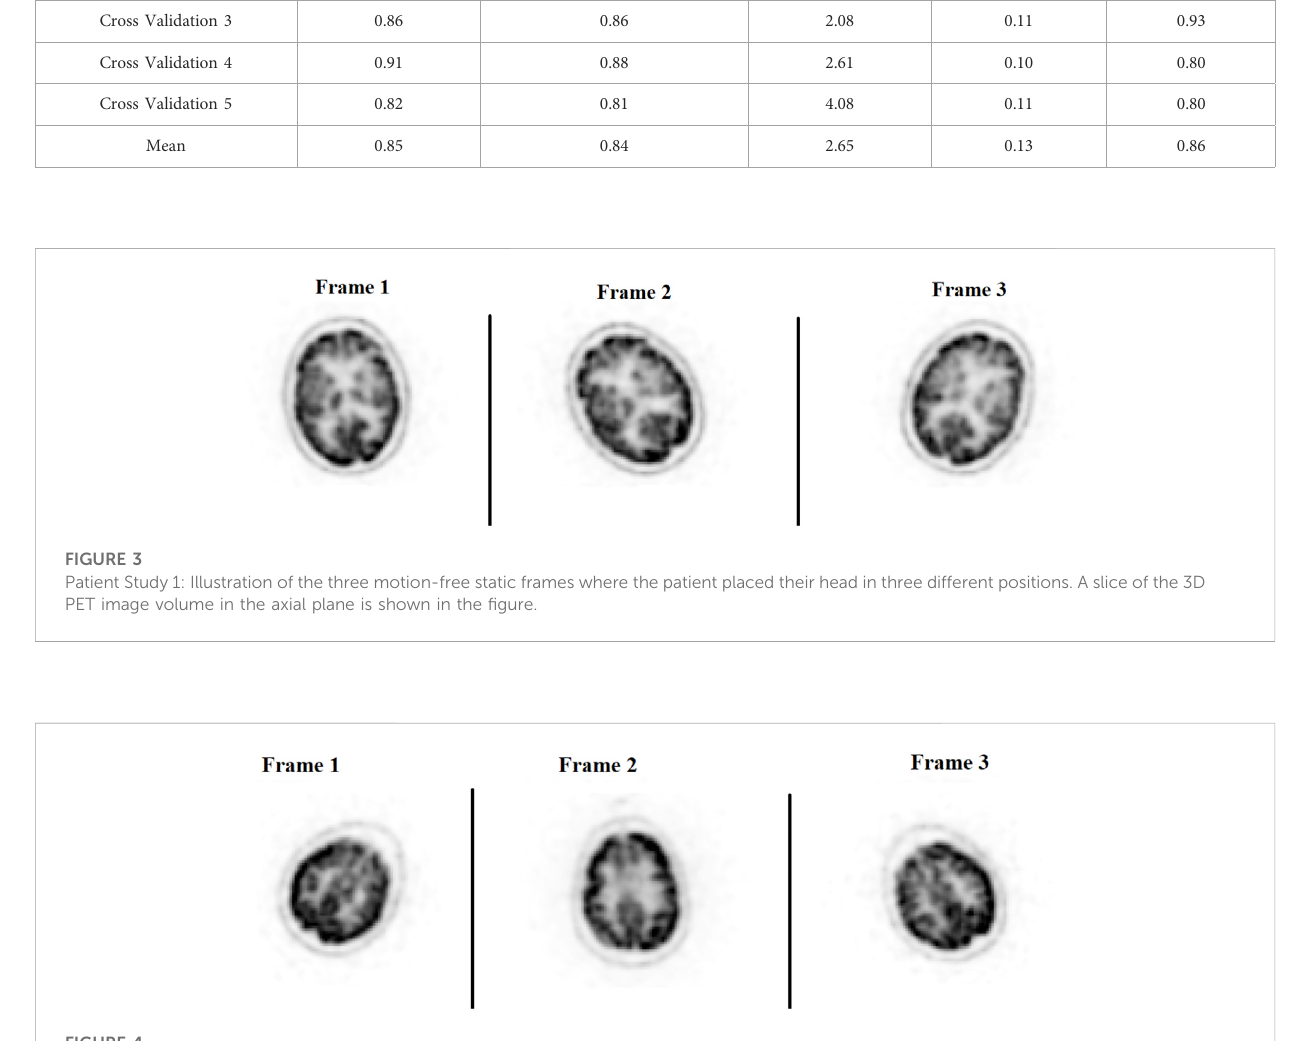
algorithm but did so ~3x and ~20x faster, respectively, using the multi-core CPU and the GPU.